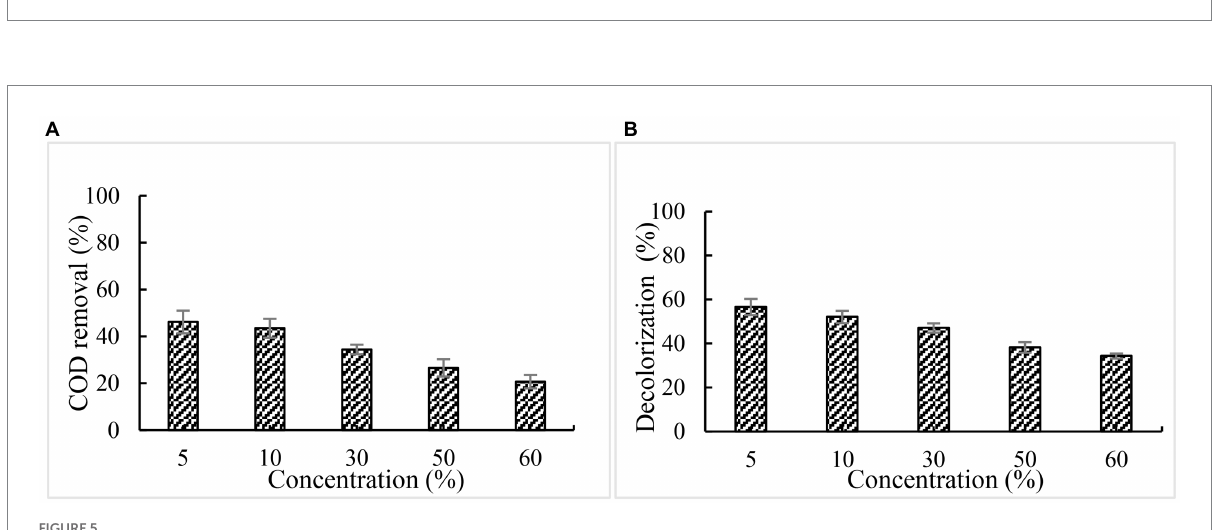
FIGURE 4 Linewaver-Burk plot of BaDyP for the oxidation of ABTS and veratryl alcohol. (A) ABTS; (B) veratryl alcohol.